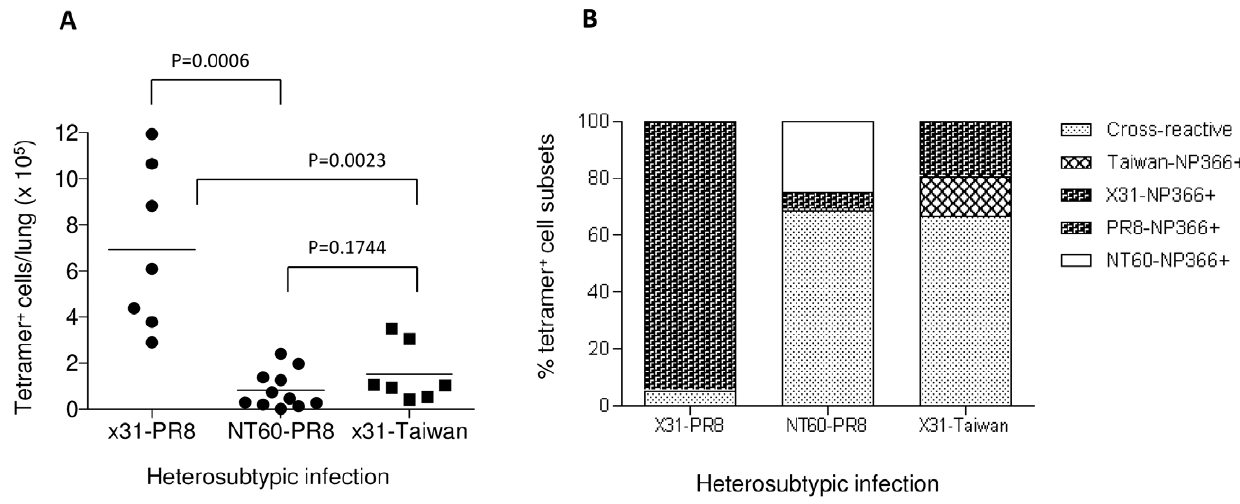
Figure 4. Magnitude and composition of specific and cross-reactive CD8 T cells to wild-type and variant NP 366 /D b epitope after heterosubtypic influenza virus infections. Five to ten B6 mice per group were primed and challenged with lethal doses of heterosubtypic influenza A viruses as described in figure 1. Lung tissues were collected from individual animals five days after the lethal challenge and examined for the magnitude of the CD8 T cell response to the wild-type and variant NP 366 /D b epitope (A). The mean percentages of the cell subsets from the same set of the data were used to assess the composition of the NP 366 /D b response specific for the original NP 366 priming sequence or cross-reactive to the NP 366 challenge variants as indicated (B).